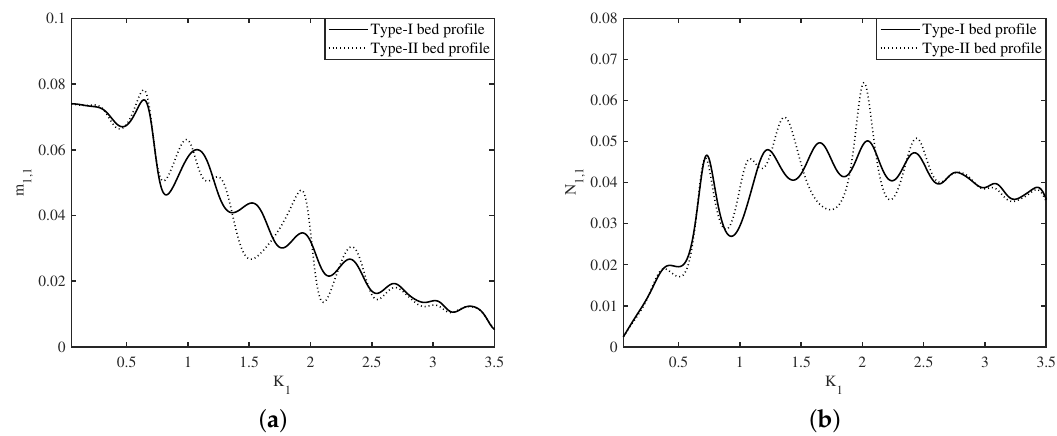
Figure 12. Variation of ( a ) m 1,1 and ( b ) N 1,1 vs K 1 for ( a ) type-I and ( b ) type-II bed profiles.